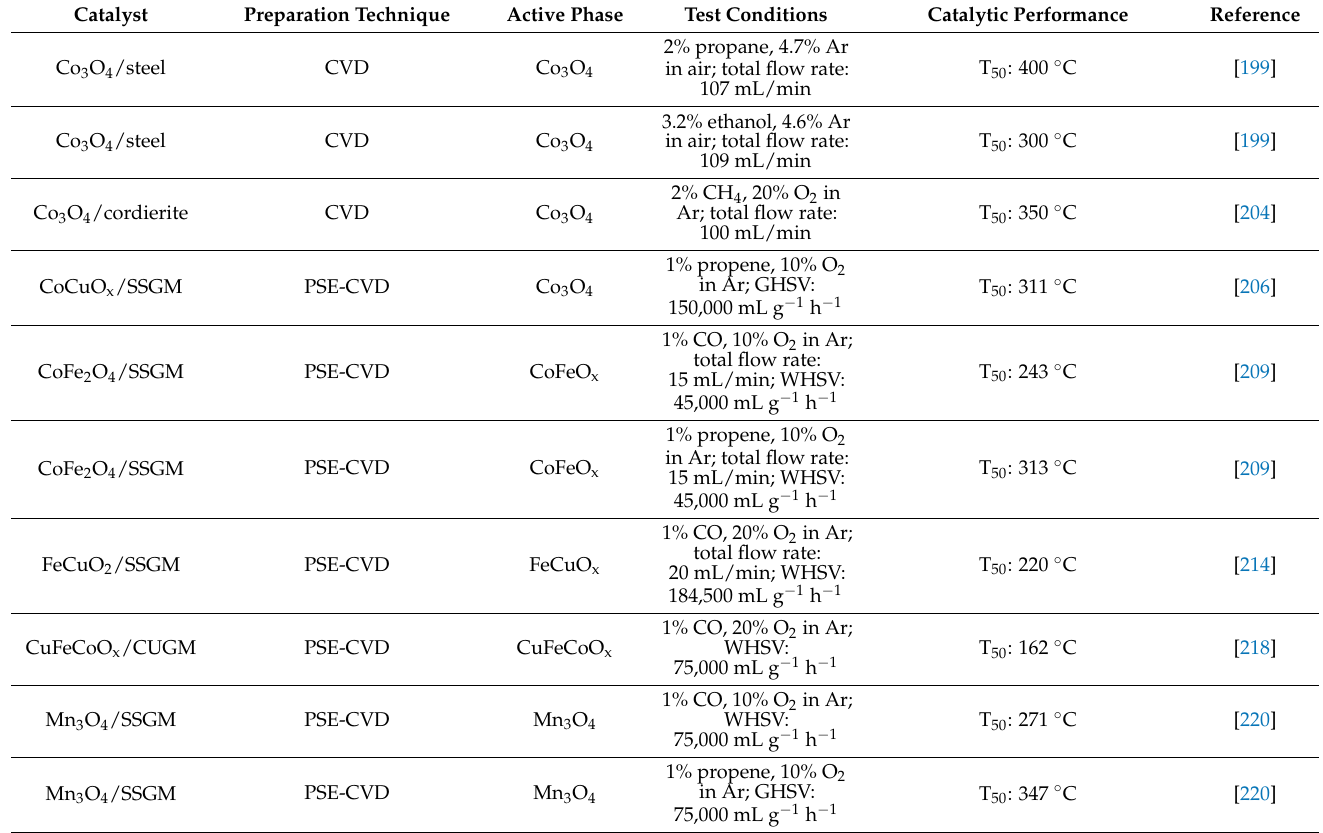
Table 3. Previous results of thin films used in transition metal oxide catalysts for combustion processes. Catalyst Preparation Technique Active Phase Test